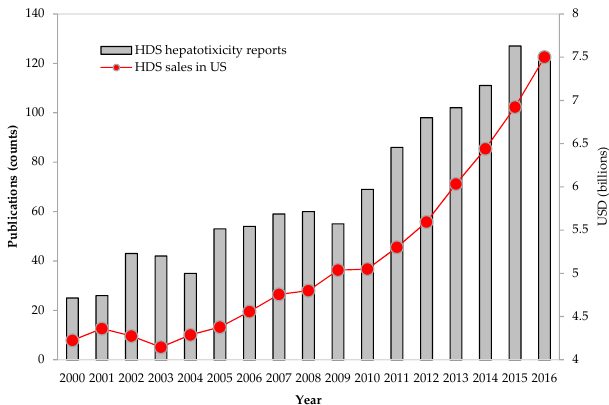
Figure 1. Increases in herbal dietary supplement (HDS) sales and in publications reporting HDS hepatotoxicity. Total sales for HDS have steadily increased in the U.S. market. With increasing HDS use, publications on liver injury due to HDS also have increased accordingly. The sources of HDS sales and publications are from the market reports in HerbalGram (http://abc.herbalgram.org/site/PageServer) and PubMed (accessed on 1 September 2017),